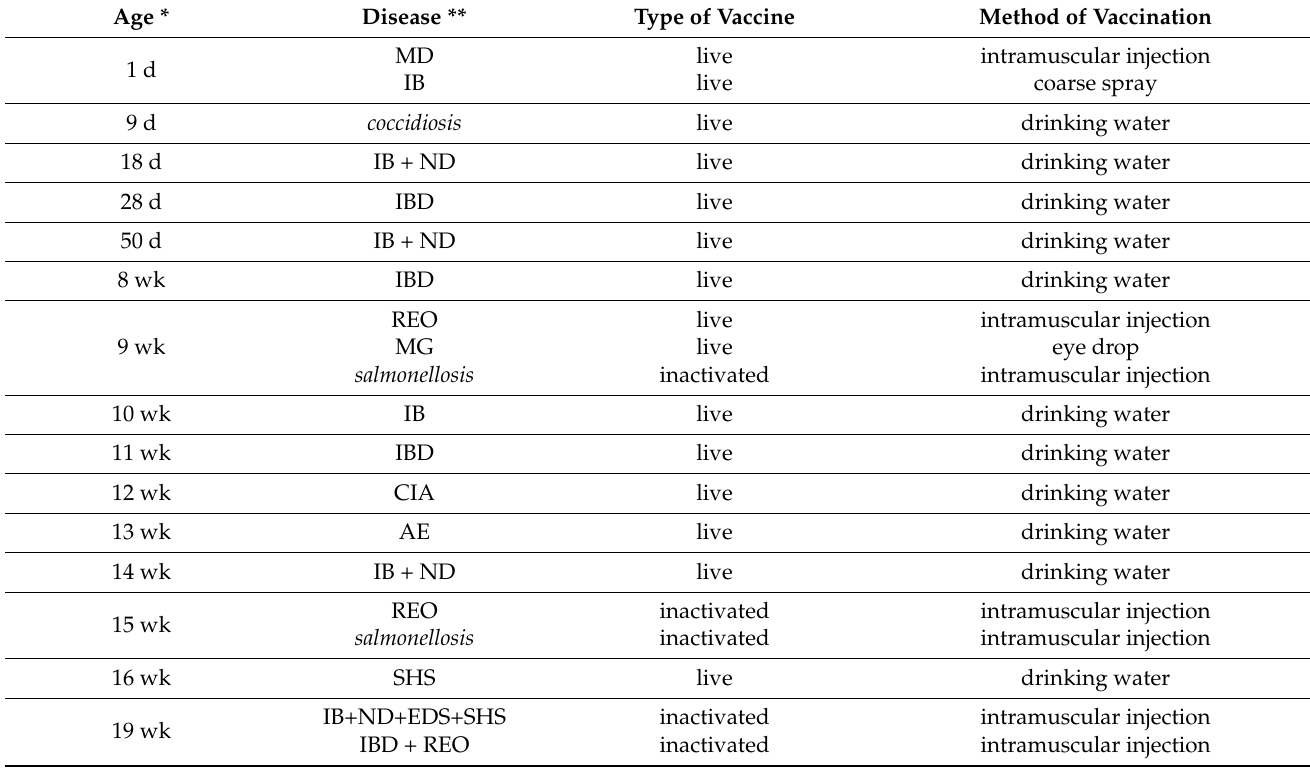
Table 1. Vaccination schedule applied at the parent-stock chickens